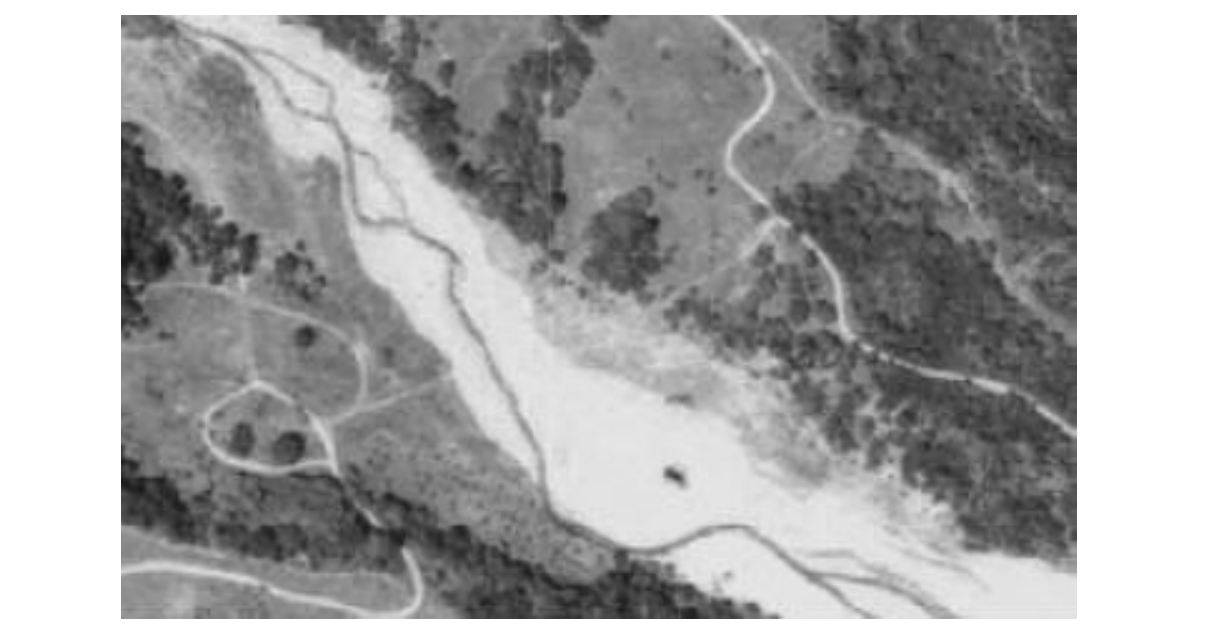
Fig. 3 . Aerial photograph, Cuneo Creek (courtesy of the California Department of Parks and